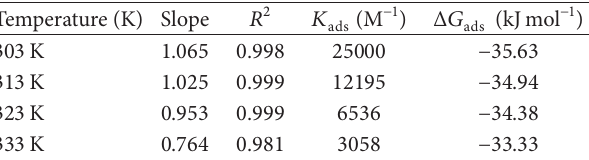
Table 2: Thermodynamic parameters for the adsorption of RS in 1M HCl on the mild steel at different temperatures.